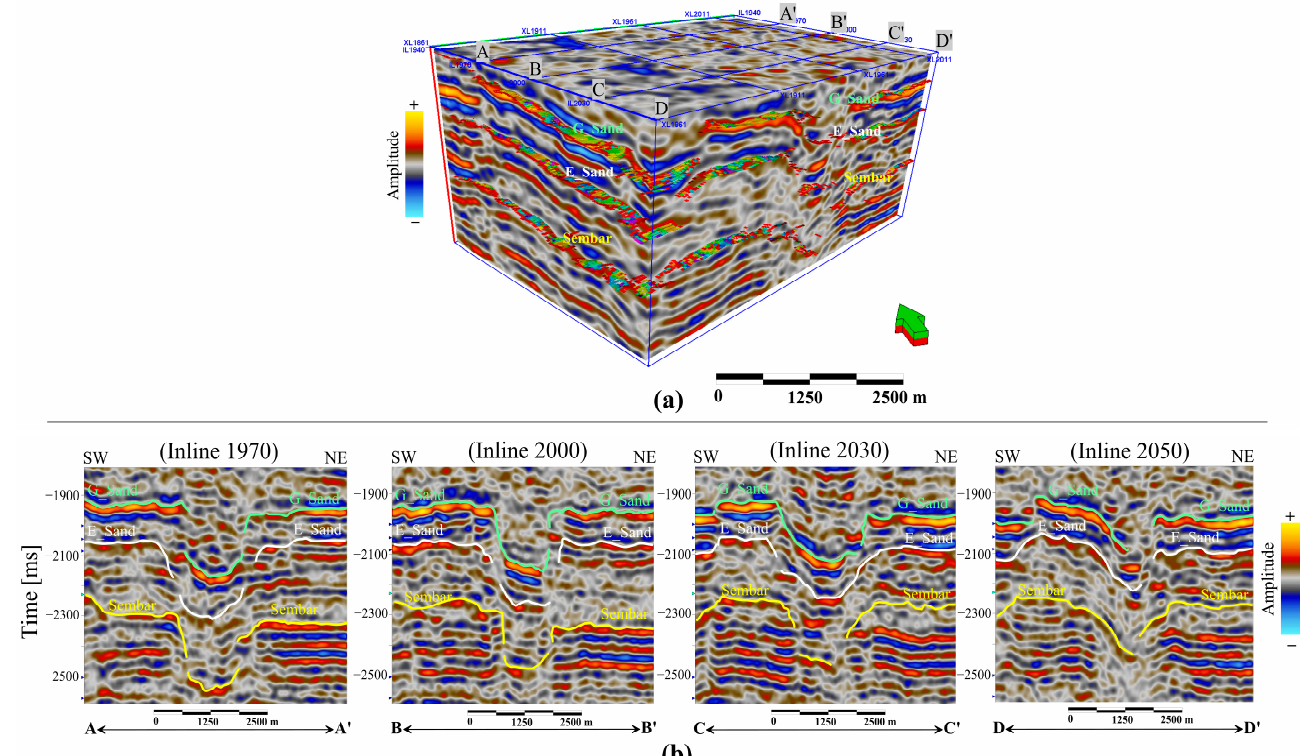
Figure 4. ( a ) 3D time-seeded horizon auto-tracking; ( b ) amplitude display of vertical time inline cross-sections (e.g., 1970, 2000, 2030, and 2050) in the SW to NE direction, showing horizon interpretation. Mint green, white, and yellow colors represent the lateral extent of the G sand interval, the E sand interval, and the Sembar Formation, respectively.